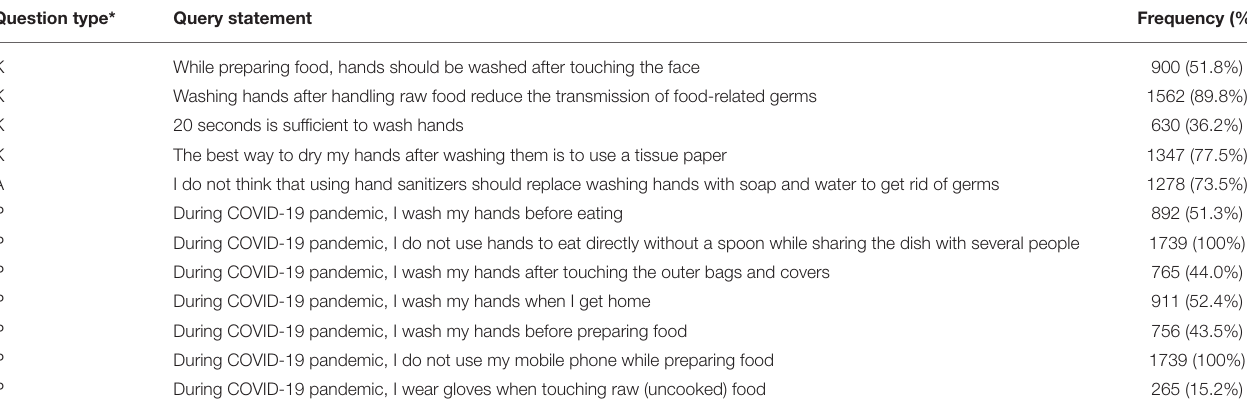
TABLE 5 | Query statements and responses of “personal hygiene” aspect.